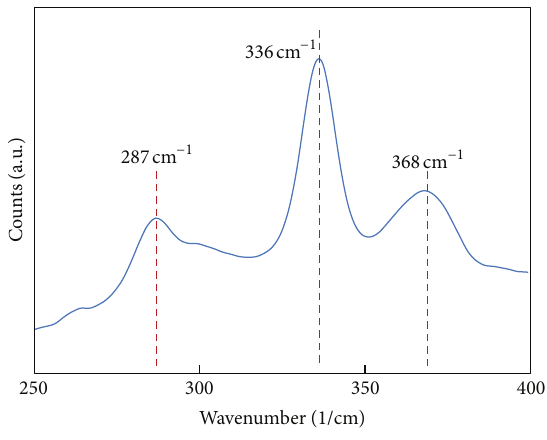
Figure 2: Raman spectrum of CZTS